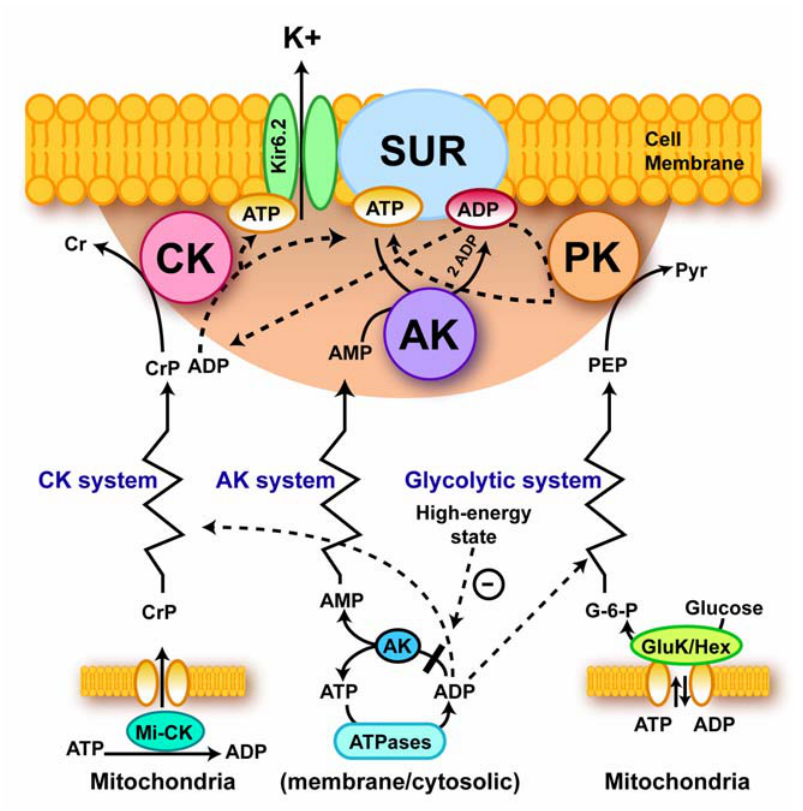
Figure 6. A paradigm of phosphotransfer-mediated energetic signaling: coupling cellular metabolic and electrical activities. Dynamic interaction between creatine kinase (CK), adenylate kinase (AK) and glycolytic (represented by pyruvate kinase, PK) channel behavior phosphotransfer relays determines a prototypic metabolic sensor - K ATP and subsequent cellular responses, such as excitability, hormone secretion, intracellular calcium homeostasis and vascular tone. The shadowed area represents a metabolic sensor “sensing zone”, where intimate local changes in nucleotide ratios are sensed and transduced into an appropriate cellular response. Phosphotransfer circuits connect the “sensing zone” with cellular processes. Dashed lines indicate pathways signaling the high- energy state, while solid lines represent low-energy state signal transmission. Kir6.2 – potassium channel subunit; SUR – sulfonylurea receptor; GluK/Hex –glucokinase and hexokinase. Reproduced from ref. [7] with